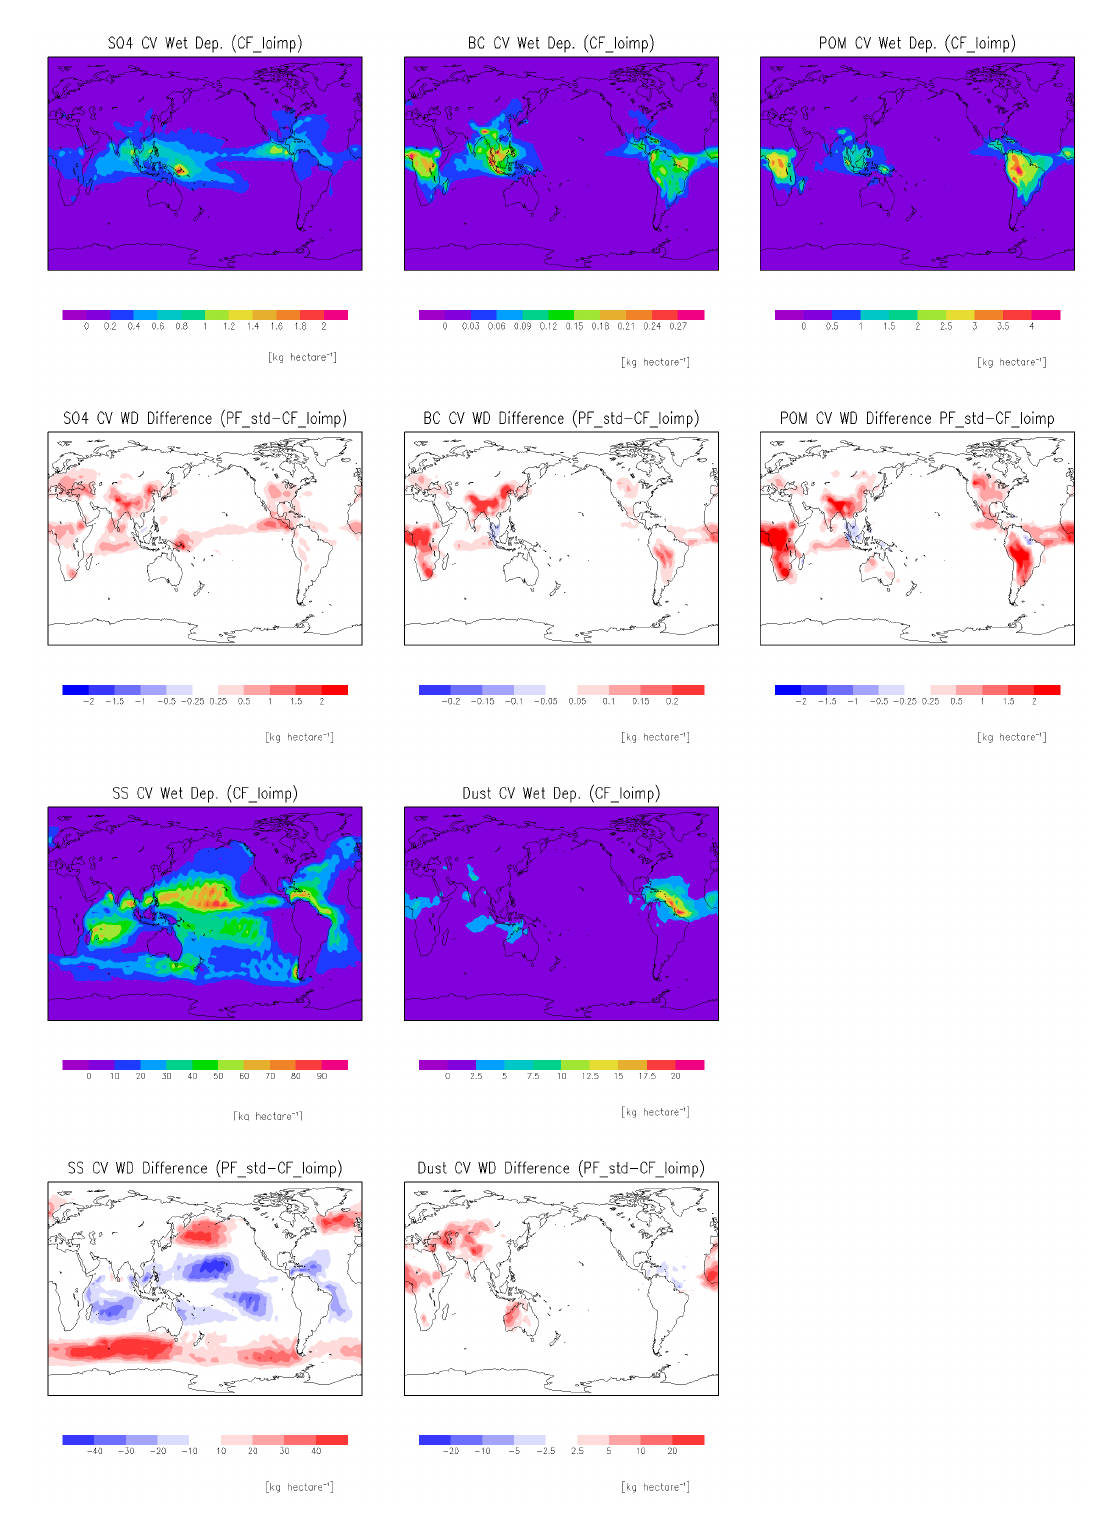
Fig. 6. The geographic distribution of annual mean convective wet deposition (CV Wet Dep.) for the simulation CF loimp and the difference of simulation PF std with respect to CF loimp for sulfate (SO 4 ), black carbon (BC), particulate organic matter (POM), sea salt (SS) and dust. Simulations are described in Table